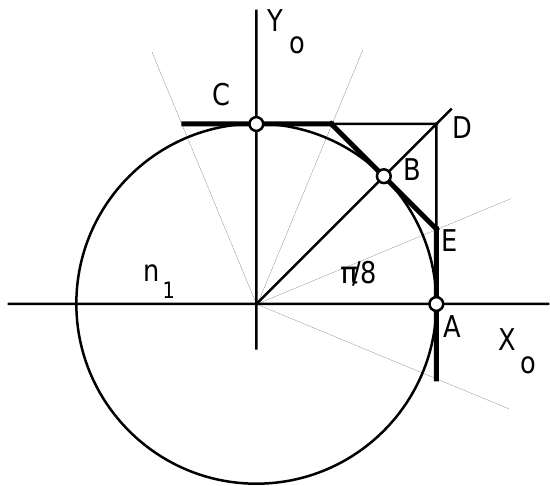
FIG. 3. The (cid:88) (cid:45) (cid:89) primary impact distribution of the simulation on the primary collimator jaws. The small circles are the scattering sources of the central impact approximation for which the betatronic phase advances were computed (see text). With (cid:109) (cid:112) (cid:173) (cid:50) , the largest amplitude before